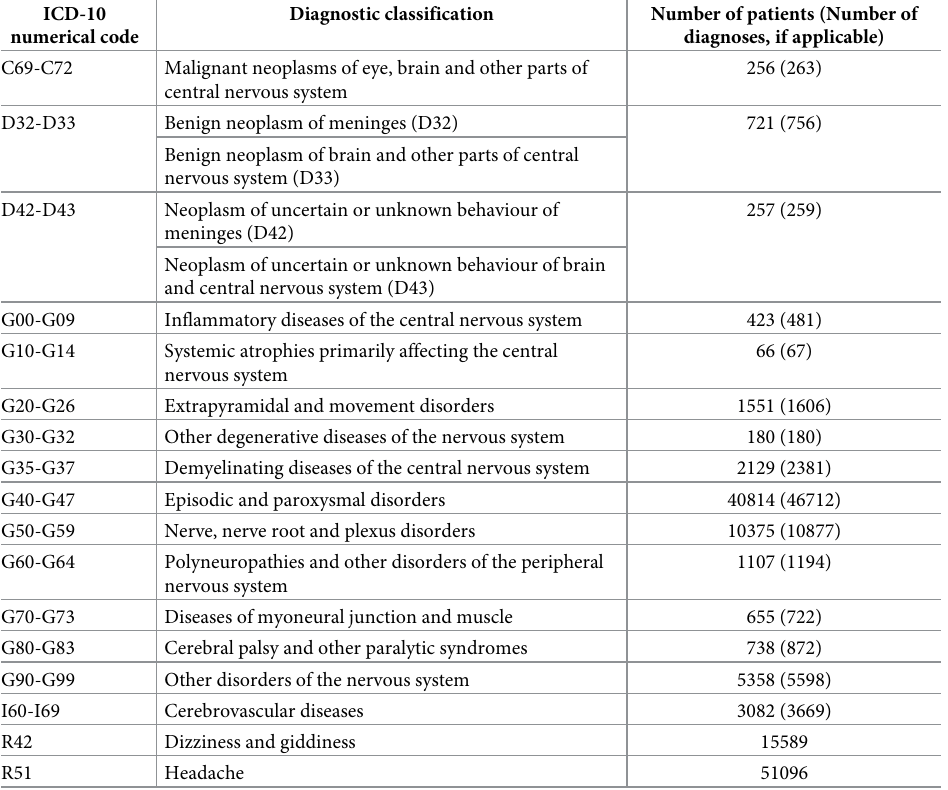
Table 1. Classification of patients by neurological diagnoses received in 2004–2016 prior to first pregnancy during the study